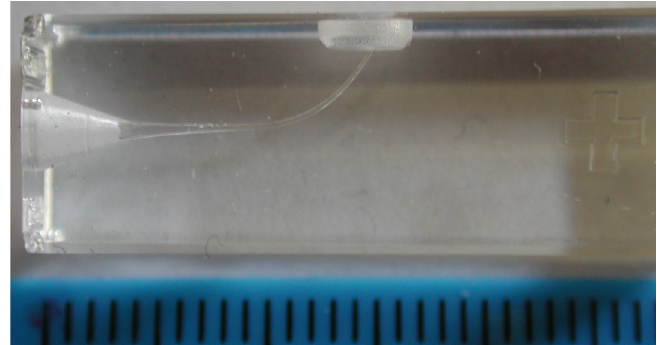
Figure 2: ENDO-TRAINING-BLOC employed as